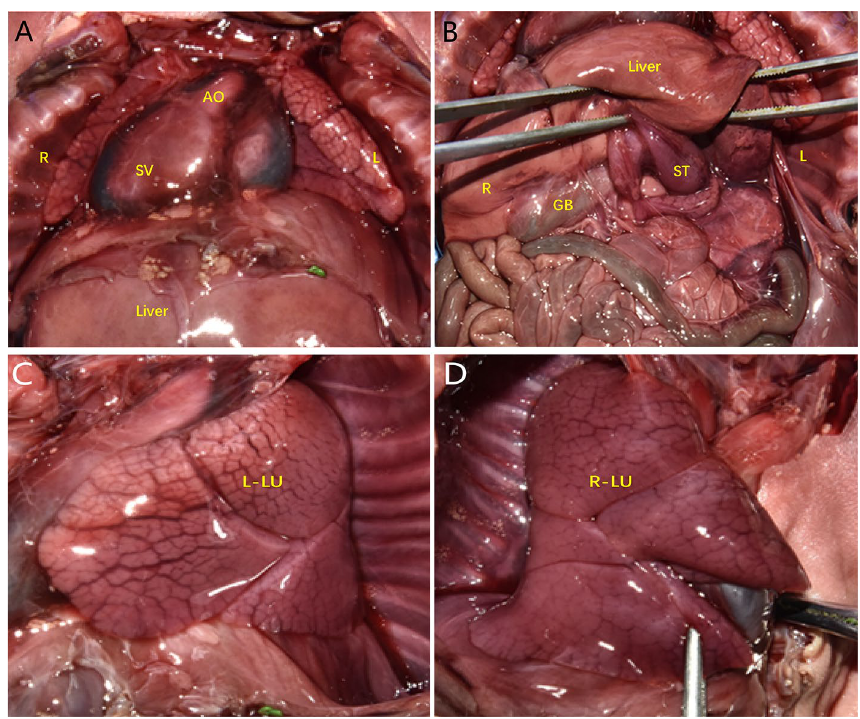
Figure 3. Examination of heart anatomy. ( A , B ) The apex of the heart was to the right, there was a single ventricle, the gallbladder and stomach were in the right and left abdomens, respectively, and a spleen was lacking. GB gallbladder, L-LU left lung, R-LU right lung, ST